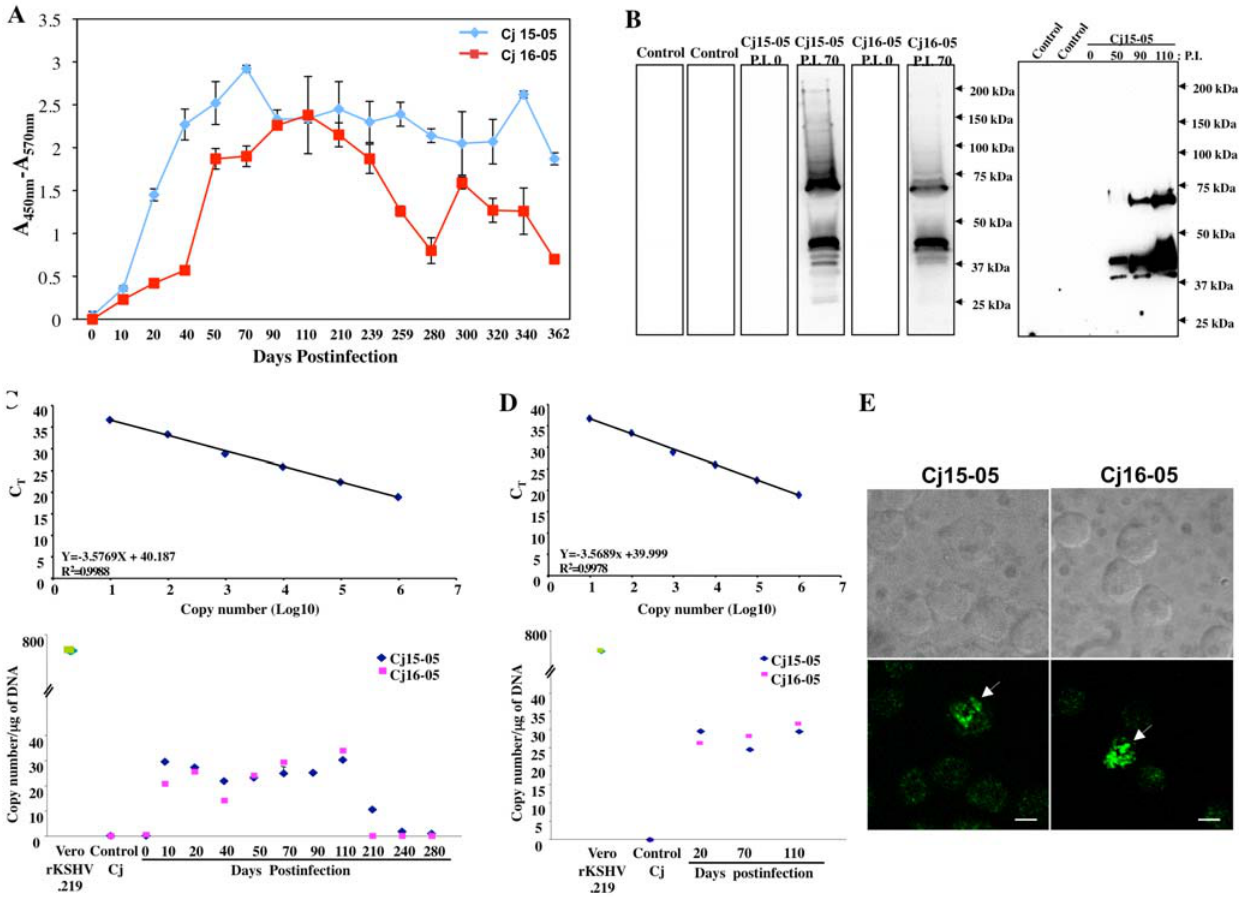
Figure 1. Experimental infection of common marmosets with rKSHV.219. ( A ) ELISA using the sera (1:100 dilution) of infected marmosets (Cj15-05 and Cj16-05) against the lysed recombinant virus. The results show the averages of four repeats and standard deviations. These assays were reproduced by at least four independent occasions. ( B ) Immunoblot using the sera of infected marmosets (Cj15-05 and Cj16-05). Sera (1:500 dilution) taken from naı¨ve control marmosets (Control) and infected marmosets (Cj15-05 and Cj16-05 in the left panel and Cj15-05 in the right panel) at various time points were used to immunoblot 20 m g of purified virion proteins. P.I., days postinfection. ( C and D ) Real-time PCR analyses of KSHV LANA and ORF9 DNA. Purified genomic DNA (100 ng) from the PBMCs of three naı¨ve controls and two infected (Cj15-05 and Cj16-05) marmosets was used for real time-PCR with primers specific for LANA (c) and ORF9 ( D ). Purified genomic DNA (100 ng) from Vero.rKSHV.219 cells was included as a control (P) in ( C ). DNA copy number was calculated using a standard curve with pcDNA3-ORF9 DNA and presented as the viral copy number per m g of DNA. M, 100-bp DNA molecular markers. The results show the averages of four repeats and standard deviations. ( E ) Detection of the LANA protein by confocal microscopy. The PBMCs of KSHV-infected marmosets were subjected to immunostaining with anti-LANA, followed by confocal microscopy. The arrows indicate LANA-positive cells. The top panels show phase contrast images of the PBMCs. The scale bars represent 20 m m. It should be noted that this picture shows an example of a rare positive field, but not reflecting the overall incidence of LANA positive